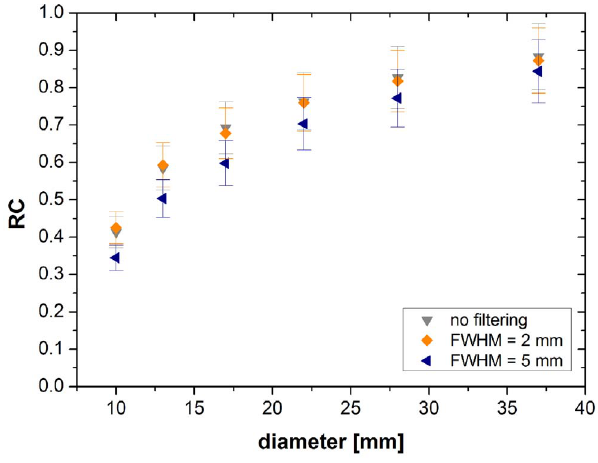
Figure 3. RC of I-124 with PGC depending on post-reconstruc- tion filtering as a function of sphere diameter. Reconstruction iterative with scatter correction and a S:BG=9.9:1.